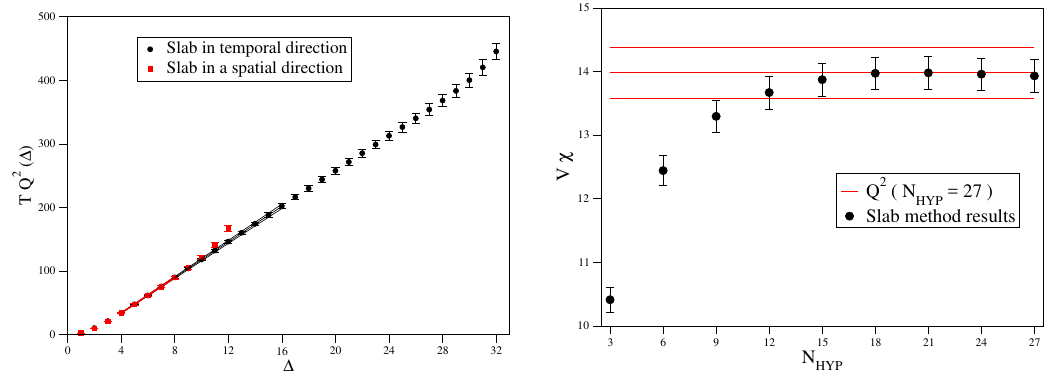
Figure 8 . Data shown here are for m 0 = (cid:0) 0 : 845. The left panel shows the determination of (cid:31) from a linear (cid:12)t to slabs along any lattice axis. The right panel compares the slab method determination (black points) to the standard measurement (1 sigma red error band).